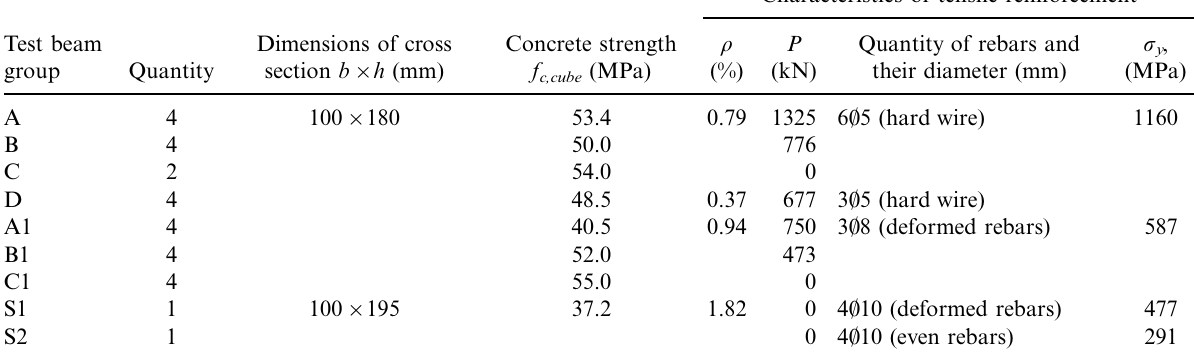
Table 1. Main parameters of experimental beams